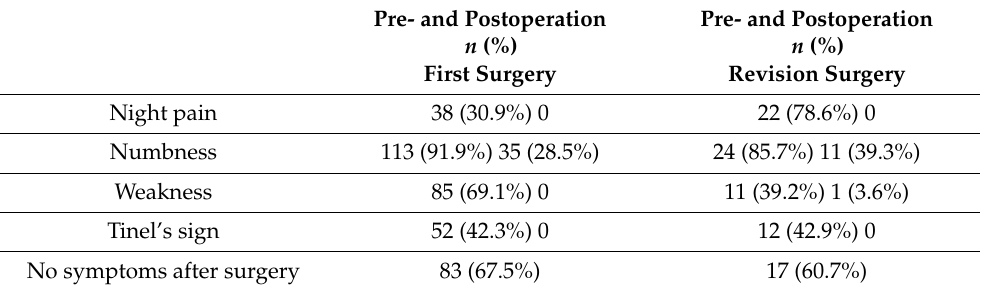
Table 2. Symptoms and signs of patients preoperatively and at 3 months postoperatively ( n = 111 patients/123 hands) after first surgery and revision surgery ( n = 28 patients/28